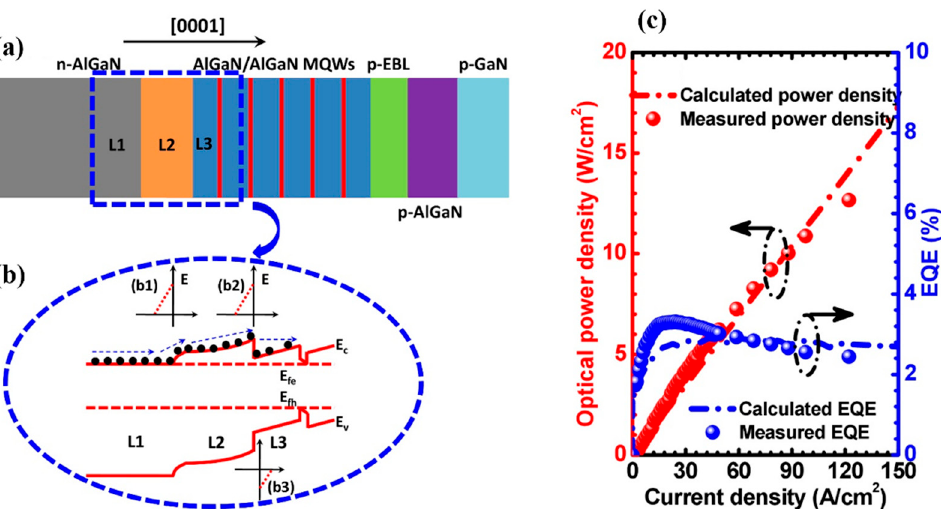
Figure 5. ( a ) Schematic structure for the (0001) oriented DUV LEDs and ( b ) schematic energy band diagram when the electron concentration and the alloy in the n-AlGaN layer were modulated. ( c ) Experimentally measured and numerically calculated optical power density and EQE as the function of the injection current density for device 1. Reproduced from Ref. [69] with permission from the Optical Society of America.